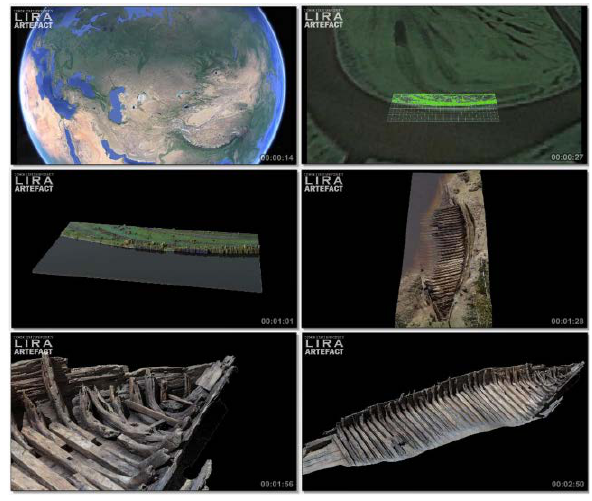
Figure 6. Thumbnails of the